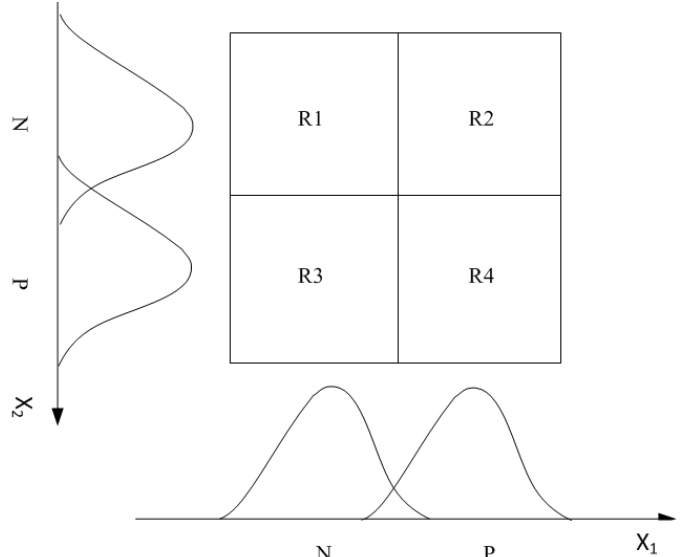
Figure 7. Gaussian membership functions for the linguistic states.